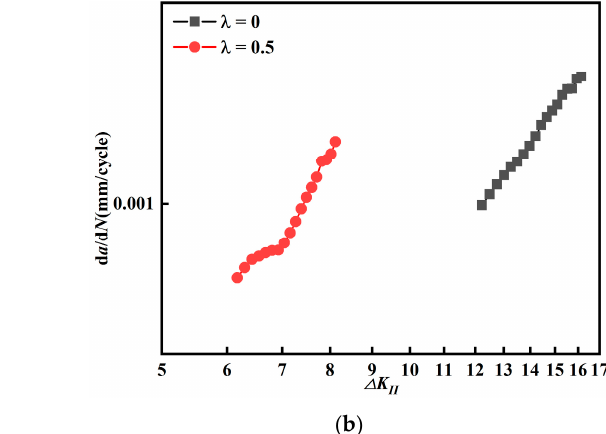
Figure 10. Relationship between stress intensity factor amplitude △ K I , △ K II , and da/dN ( β = 60°). ( a ) Relationship between △ K I and da/dN . ( b ) Relationship between △ K II and da/dN .